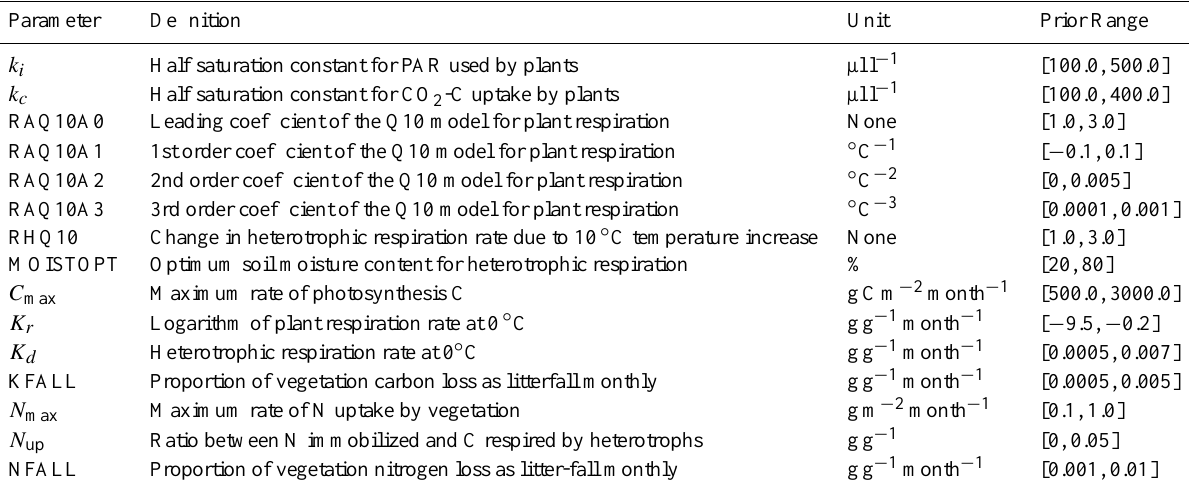
Table 3. Key TEM